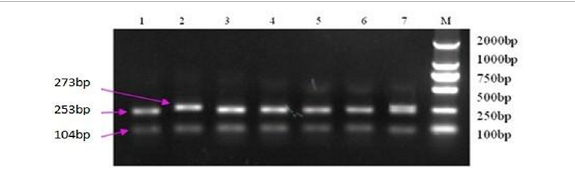
Fig 1. Results of Sty I-enzyme digestion at loci E10 (+109). M lane is the DL2000 marker, bands of 273, 253, 104, 20 bp for the A/G genotype in lane 1 and 20bp is invisible in the figure, bands of 253, 104, 20bp for G/G genotype in lanes 2,3, 4, 5, 7, bands of 273, 104 bp for A/A genotype in lane